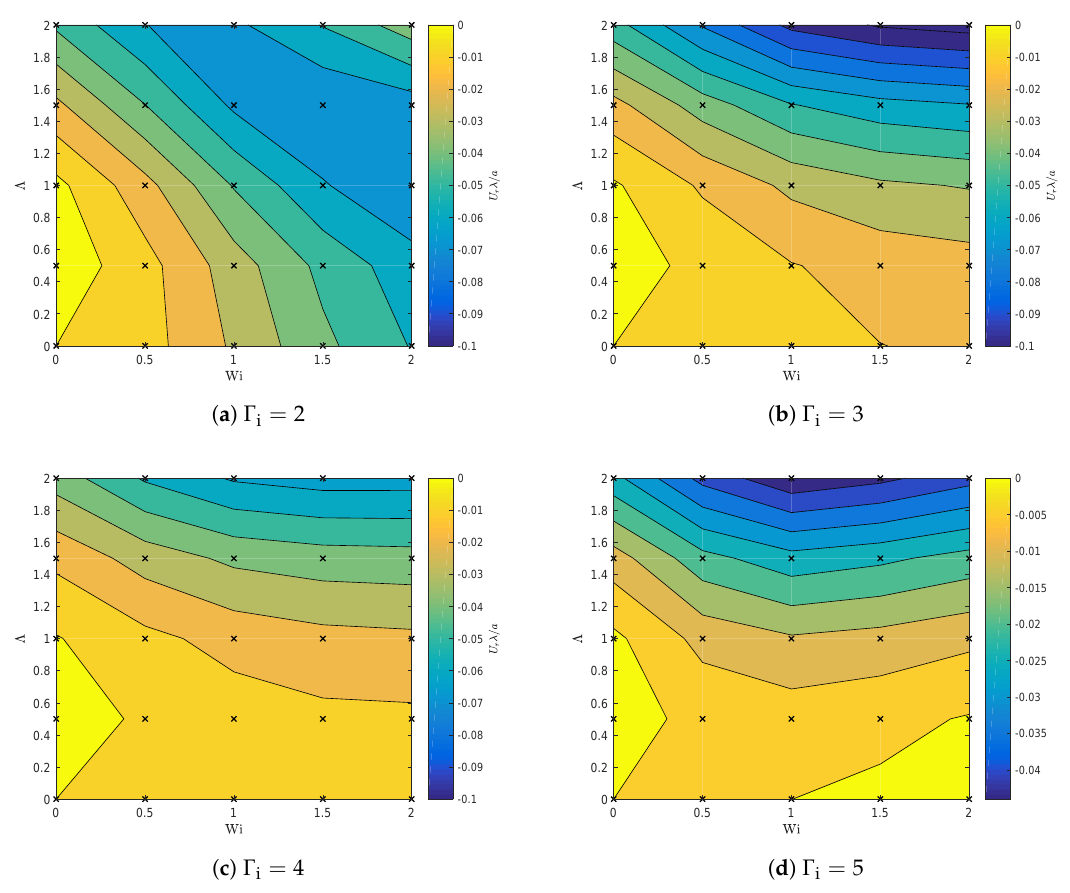
Figure 10. Contour plots of the migration velocities for combined shear and sedimentation flows. Markers x indicate the data points; between these points, the data are interpolated using the MATLAB R (cid:13) function